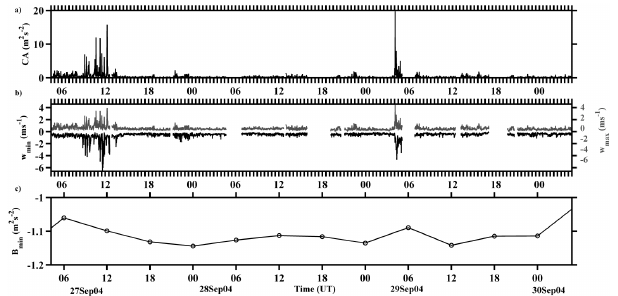
Figure 5. (a) Plot of Convective Activity (CA) (m 2 s -2 ), (b) Vertical velocity (ms -1 ) in downward 673 Fig. 5. (a) Plot of convective activity (CA) (m 2 s − 2 ) , (b) vertical ve- (w min, black) and upward (w max, gray) direction during the radar observation and (c) Minimum 674 locity (ms − 1 ) in downward ( w min , black) and upward ( w max , gray) Sub-cloud Buoyancy (B min) (ms -2 ) calculated using ERA-Interim Temperature profiles for 27-30 675 direction during the radar observation and (c) minimum sub-cloud buoyancy ( B min ) (ms − 2 ) calculated using ERA-Interim tempera- September 2004. (Note: LT = UT + 05:30 hrs) 676 ture profiles for 27–30 September 2004. (Note: